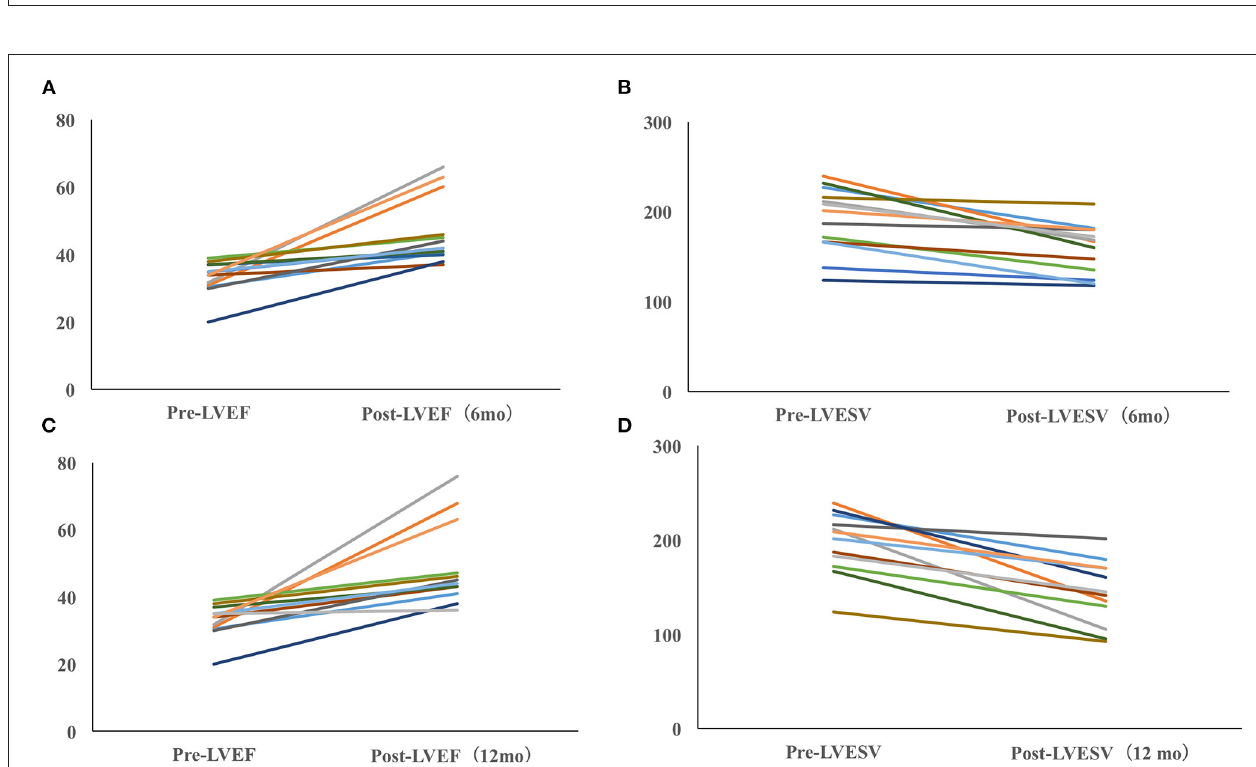
FIGURE 3 | Dynamic echocardiographic changes in PICM patients with baseline LVEF < 40%. Improvement of LVEF (A) and LVESV (B) in PICM patients with LVEF < 40% (6 months). Improvement of LVEF (C) and LVESV in PICM patients with LVEF < 40% (12 months) (D) . Data were available in 13/14 patients at the 6-month follow-up and in 12/12 patients at the last